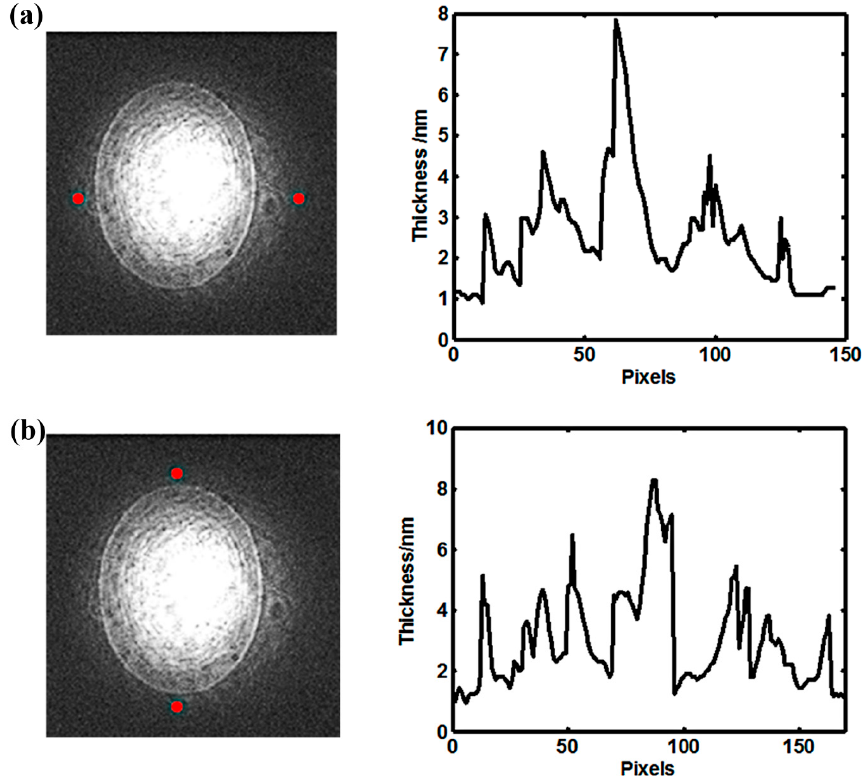
Figure 5. The thickness distribution of the lipid film deposited on the substrate including the transverse distribution ( a ) and the vertical distribution ( b ).